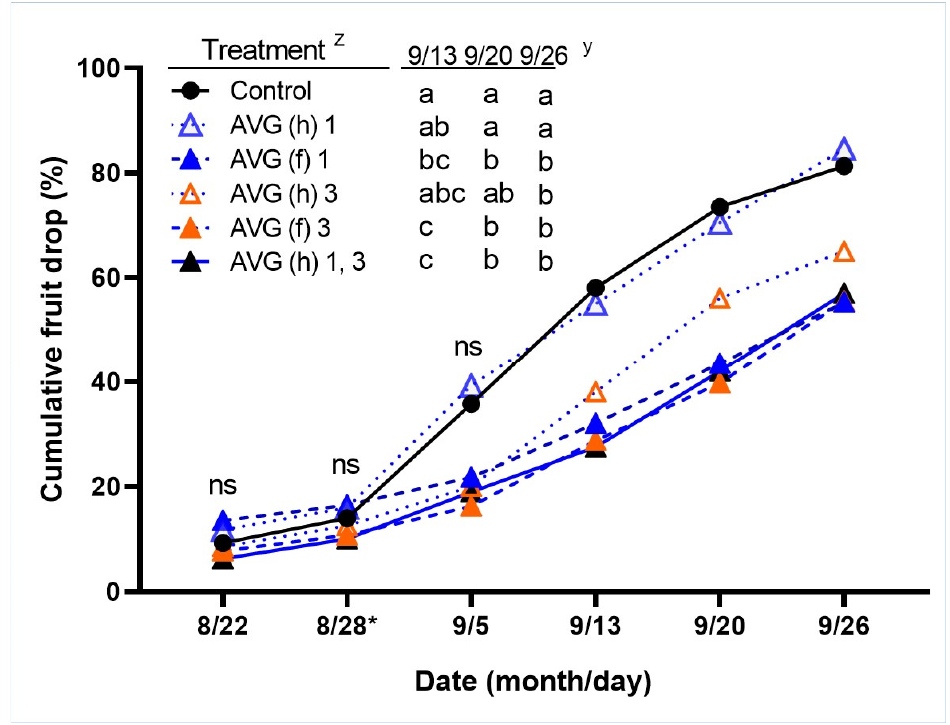
Figure 1. Effects of AVG on preharvest fruit drop of ‘Brookfield Gala’ apples in 2018. Z, letter h in parentheses represents the half-rate (65 mgL − 1 ), and letter f represents the full-rate (130 mgL − 1 ); numbers in each treatment indicate the numbers of weeks before anticipated harvest (WBAH) when the treatment was conducted. Y, means not sharing any letter are significantly different by the Tukey’s HSD test ( p < 0.05). *, date of harvest. Table 1. Effects of AVG on fruit quality of ‘Brookfield Gala’ apples at harvest and after cold storage, 2018, Exp.